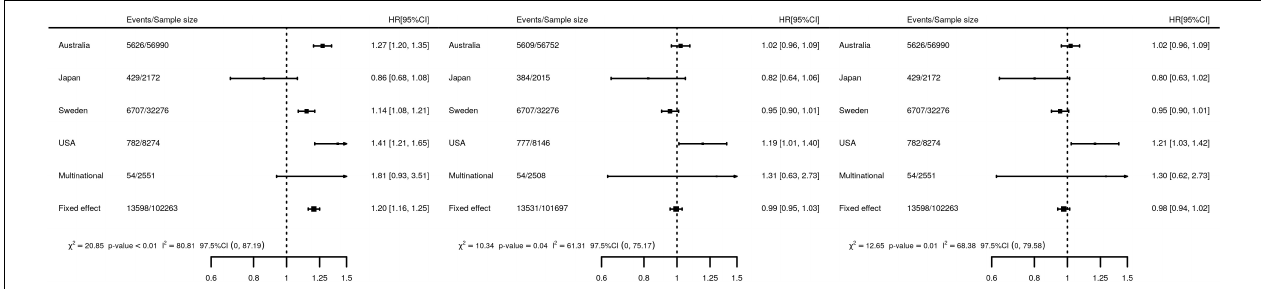
FIGURE 3 | Forest plots of the association of female sex with the time to post-CABG mortality. Left panel, a crude Cox PH model, regressing the time to event on sex, without accounting for difference in risk factors of post-CABG survival. Middle panel, a study-specific adjusted model accounting potential risk factors observed for more than 90% of the subjects. Specifically, five covariate models were meta-analyzed where the sex variable was adjusted for the following variables: (I) United States, NNECDSG covariates: off-pump, age, BMI, hypertension, T2DM, creatinine, MI, Kidney disease, number of DV, HF, AF, COPD, PVD, LVEF. (II) Japan, CREDO-Kyoto covariates: off-pump, age, BMI, hypertension, T2DM, creatinine, MI, Kidney disease, number of DV, Stroke, HF, COPD, PVD, LVEF (III) Swedish, SWEDEHEART covariates: off-pump, age, BMI, hypertension, T2DM, creatinine, MI, Stroke, HF, AF, COPD, number of graft PVD. (IV) Australia, ANZSCTS covariates: off-pump, age, BMI, hypertension, T2DM, creatinine, MI, number of DV, Stroke, HF, AF, COPD, number of graft, PVD. (V) Multinational, IMAGINE trial covariates: off-pump, age, BMI, hypertension, T2DM, creatinine, MI, number of DV, Stroke, AF, number of graft, PVD. Right panel, multi-level, multiply imputed Cox PH model adjusting for age, BMI, left ventricular ejection fraction, creatinine, number of grafts, number of diseased vessels, whether the procedure was performed on or off-pump, previous MI, history of: hypertension, stroke, AF, T2DM, COPD, HF, PVD, and kidney failure. HR, hazard ratio; 95%CI, 95% confidence interval; heterogeneity statistics include Q-tests ( χ 2 ) and I 2 as well one-sided 97.5% confidence intervals. Random effects estimates are presented in Supplementary Appendix Table 4 .